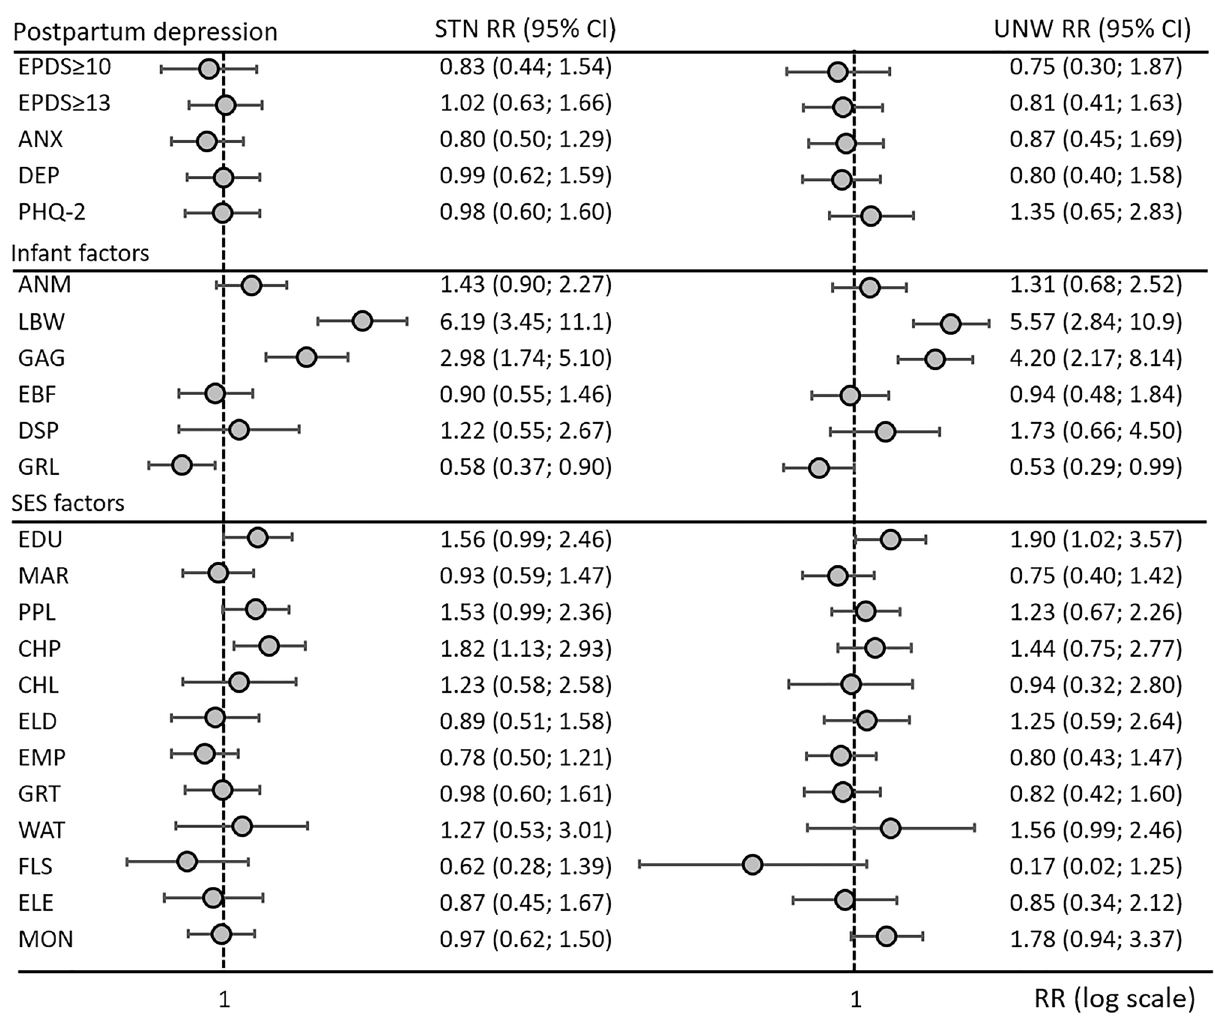
Figure 3. Association between all variables under investigation with stunting (STN) and underweight (UNW). Multivariate adjusted relative risk and 95% confidence intervals adjusted for mother’s